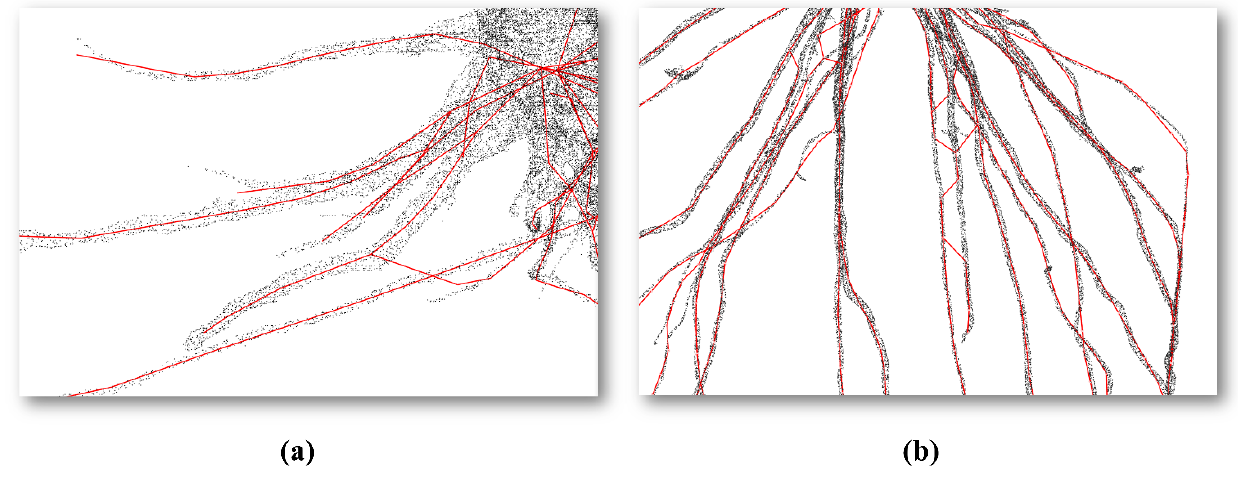
Figure 3. Problematic zoom samples of the skeleton extraction in tomato (a) and corn (b), in red with the digital twin in